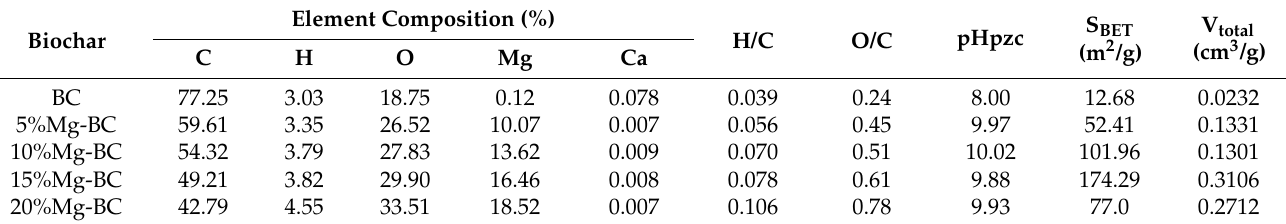
Table 1. Physiochemical properties of